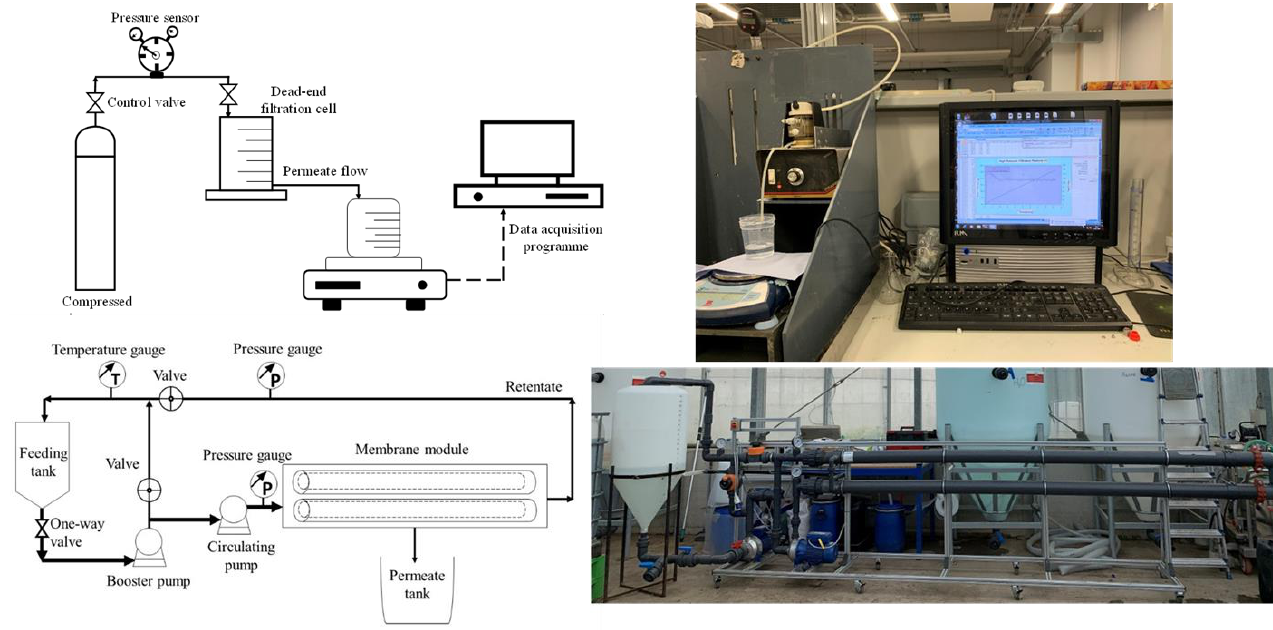
Figure 1. Schematic diagram and picture of the laboratory frontal (dead-end) filtration equipment (top) and the commercial crossflow filtration rig with KOCH ABCOR ® tubular membrane (bottom).